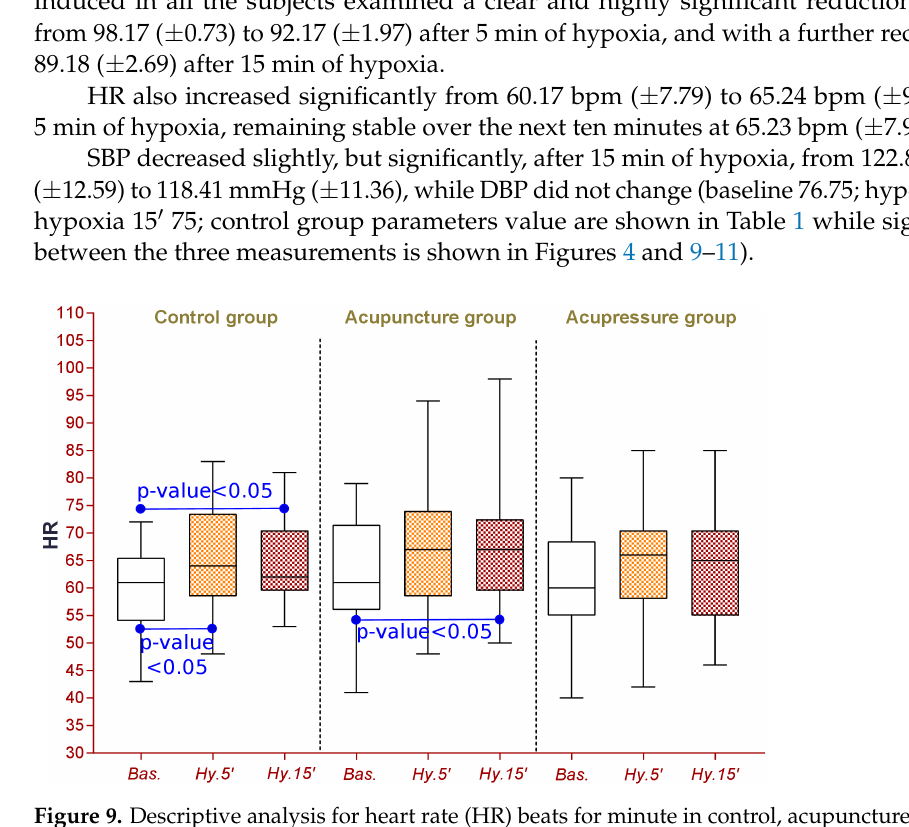
Figure 8. Calculated as in Table 2. Resistive Index (RI) in control, acupuncture, and band (acupressure) groups at baseline and after 5 and 15 min of hypoxia. Table 1. Interquartile ranges (IQR), mean and standard deviation (sd) of oxyhaemoglobin saturation (SaO 2 ), heart rate (HR), systolic and diastolic blood pressure (SBP and DBP) in controls, acupuncture and acupressure groups at baseline and after 5 and 15 min of hypoxia.